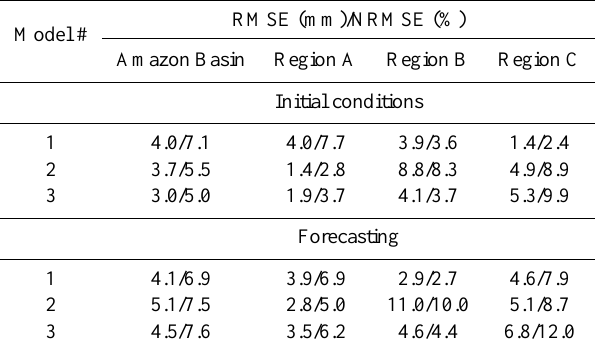
Table 4. Initial condition and forecasting uncertainties averaged over each region delineated in Fig. 1.